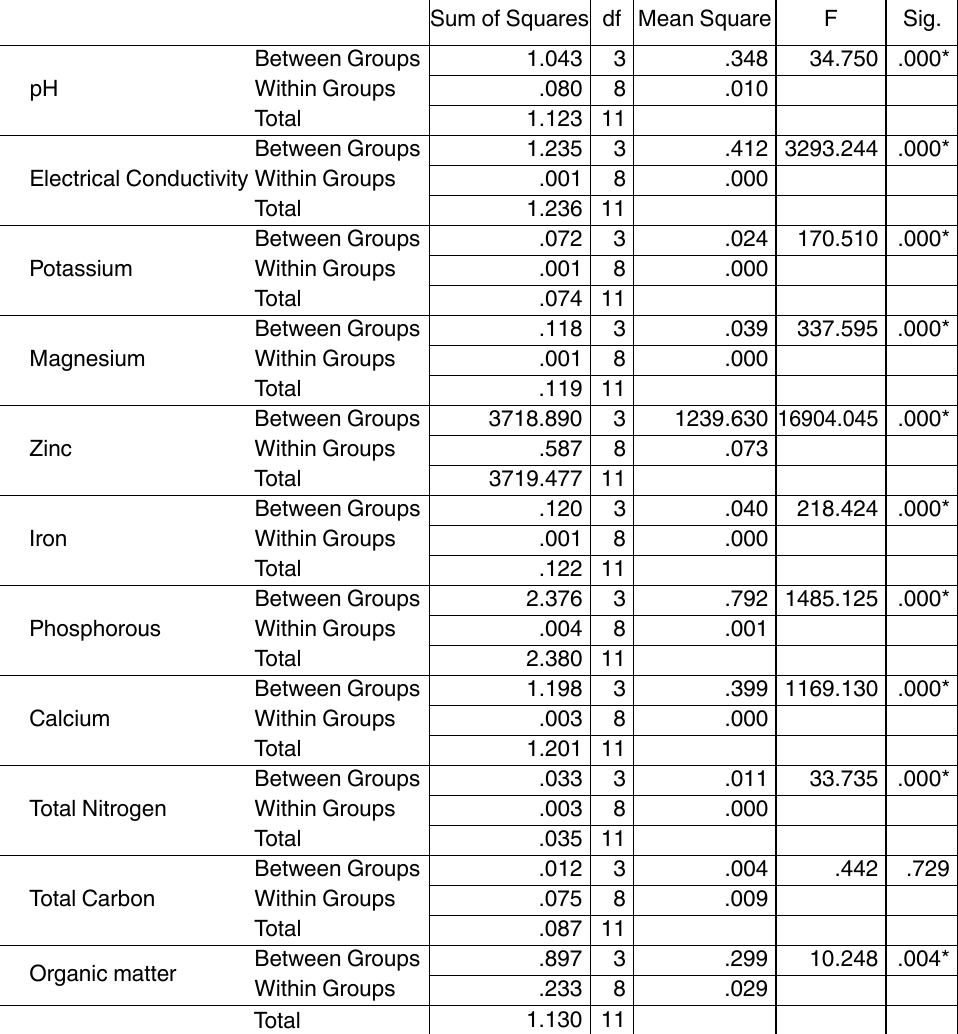
table 3 . One way analysis of variance between the experimental groups and the biochemical parameters